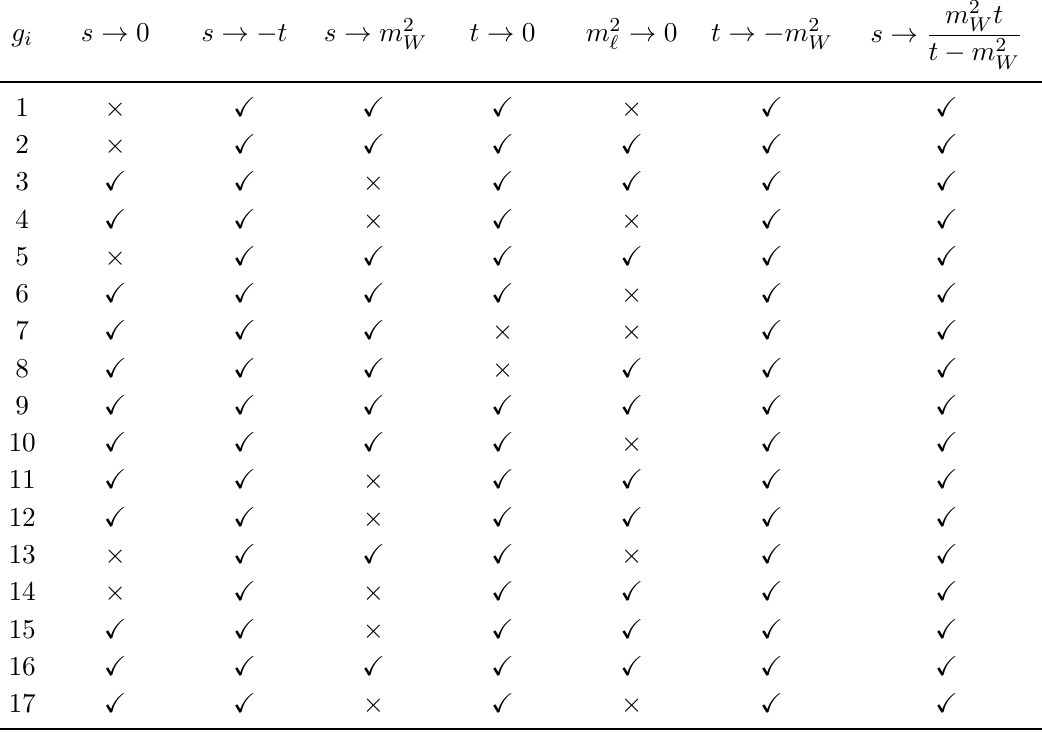
, s → − t , s → m 2 ) , t → 0 , t → − m 2 t/ ( t − m 2 W W W W